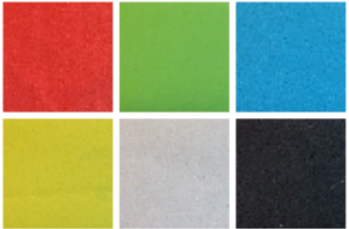
Figure 6. The six colors of the rectangular cuboid targets used during the static acquisitions (red, green, blue, yellow, white and